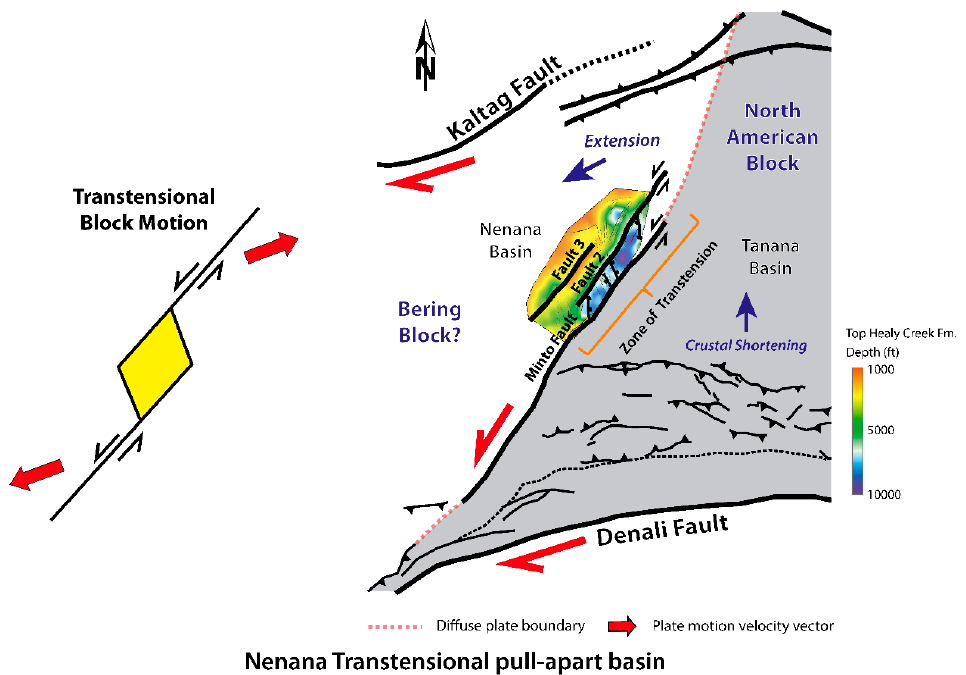
Figure 14. Simplified tectonic deformation model of the transtensional Nenana pull-apart basin. In this model, two left-lateral, oblique-slip master faults (Minto Fault and Fault 2) overlap, forming a releasing bend. A cross-basin transverse fault zone, marked by a distinct intra-basin high, further divides the basin into two discrete depocenters. The geometries of these basin depocenters are further controlled by the oblique-extensional deformation along the major basin-bounding faults (Fault 2 and Minto Fault). The formation of sub-basins along the western margin of the Nenana basin exhibits SW-ward extrusion of Bering block relative to the North American craton.